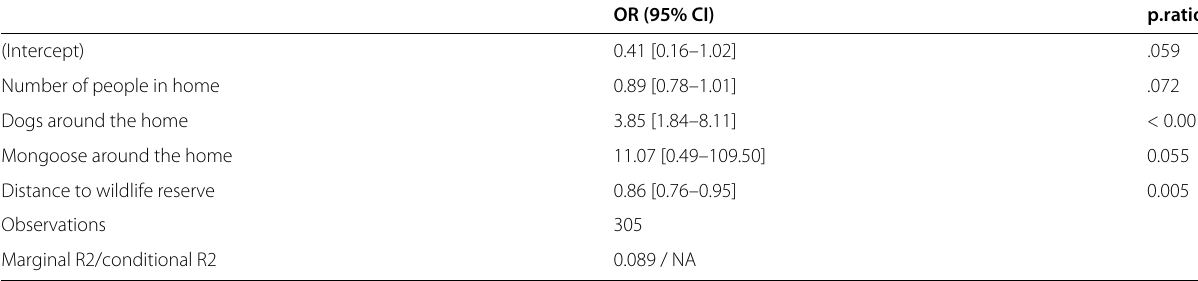
Table 4 Multivariate model of household